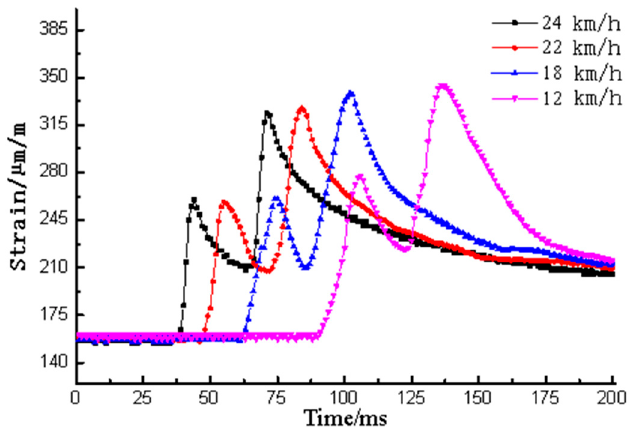
Figure 9. Relationship between vehicle speed and maximum transverse tensile strain at the base of the layer.